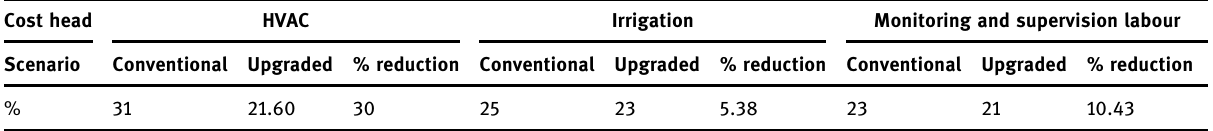
Table 8: Energy portfolio reduction comparison ( before and after upgradation